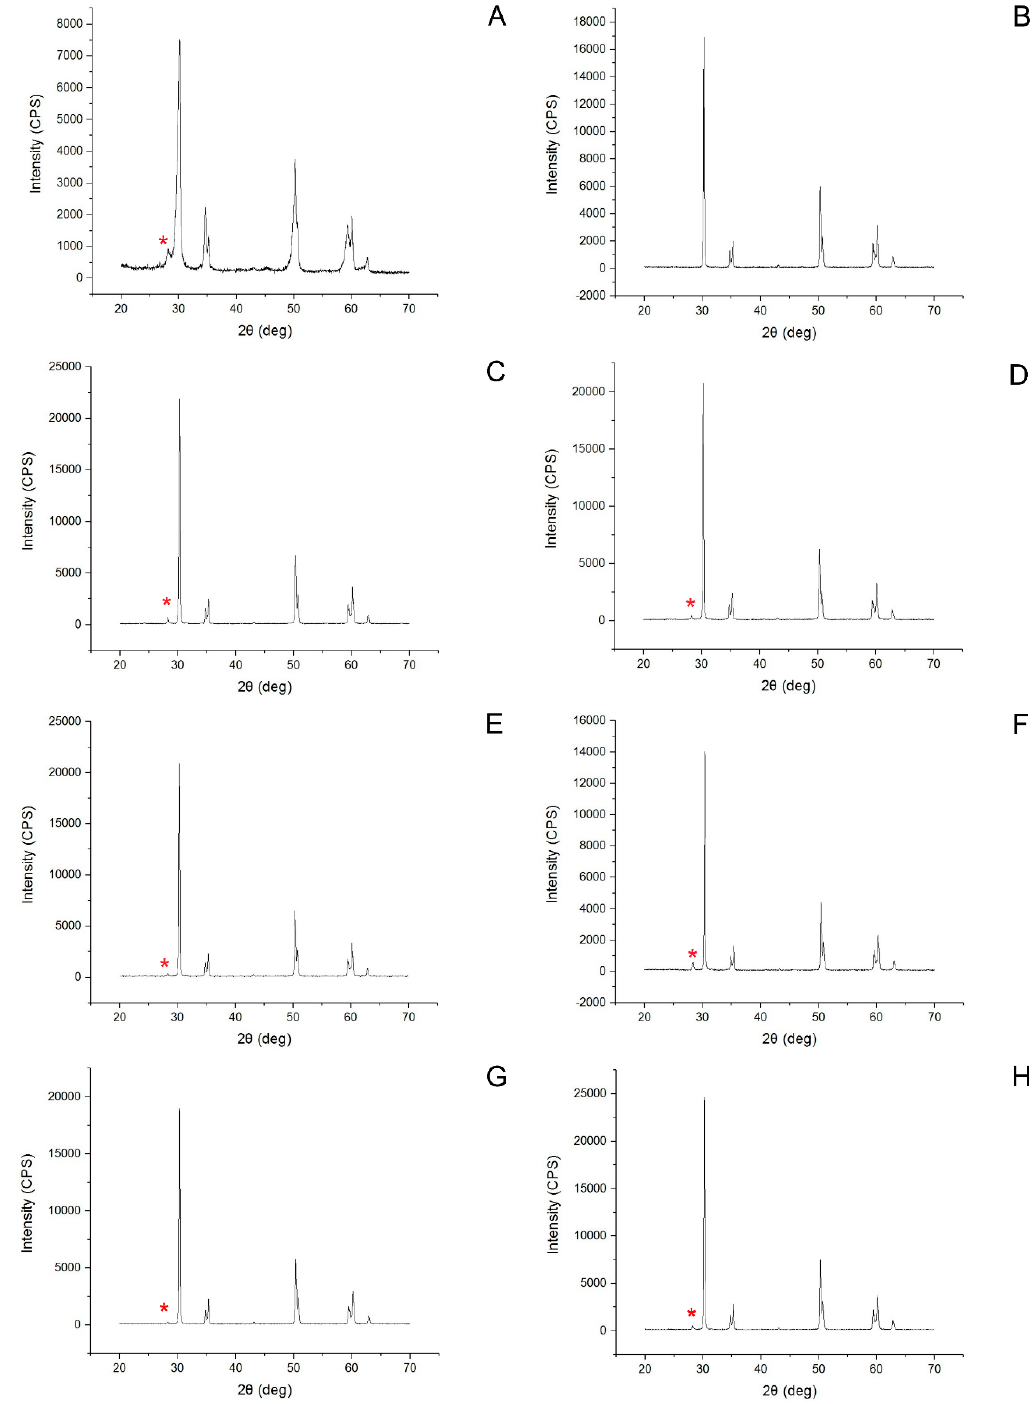
Figure 2. X-ray diffraction pattern of each group: ( A ) Control; ( B ) NoHF; ( C ) 20HF1; ( D ) 20HF2; ( E ) 30HF1; ( F ) 30HF2; ( G ) 40HF1; ( H ) 40HF2. Note that monoclinic peaks (*) were identified in all groups except for the group NoHF.